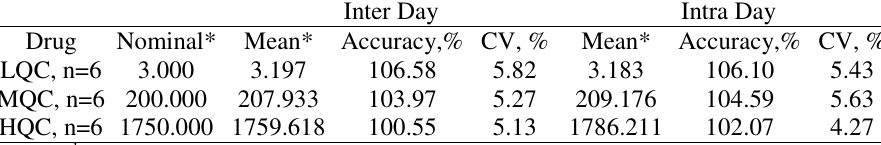
Table 3. Data of inter day precision and